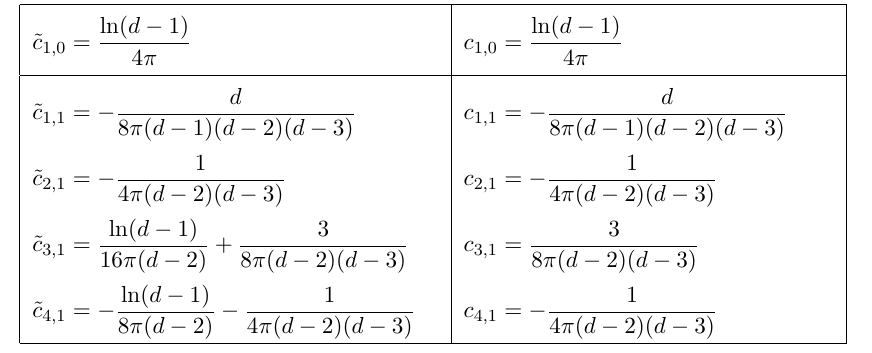
~ c 1 ; 0 and c 1 ; 0 are read from eq. (2.28) and eq. (2.32). ~ c i; 1 is the coe(cid:14)- ~ K (0) ij ; ~ R (0) ; ~^ R (0) g in eq. (2.29) and c cient of [ ~ R (0) ; ~ K (0) ] 2 = f ~ K (0)2 ; ~ K (0) i ij [ R ; K ] 2 = f K 2 ; K ij K ij ; R; ^ R g in eq. (2.37). It is valid up to holographic spacetime dimension 5 i or